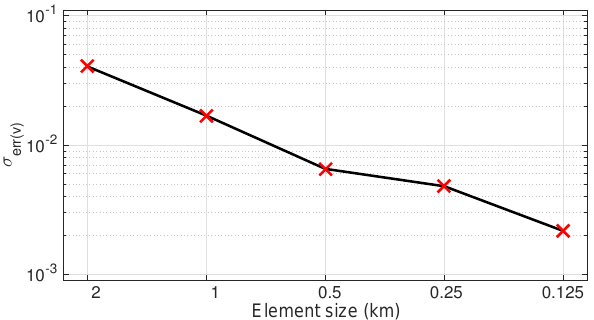
Figure A2. Standard deviation of the relative numerical error in advection velocity of the 0 level set depending on element size.